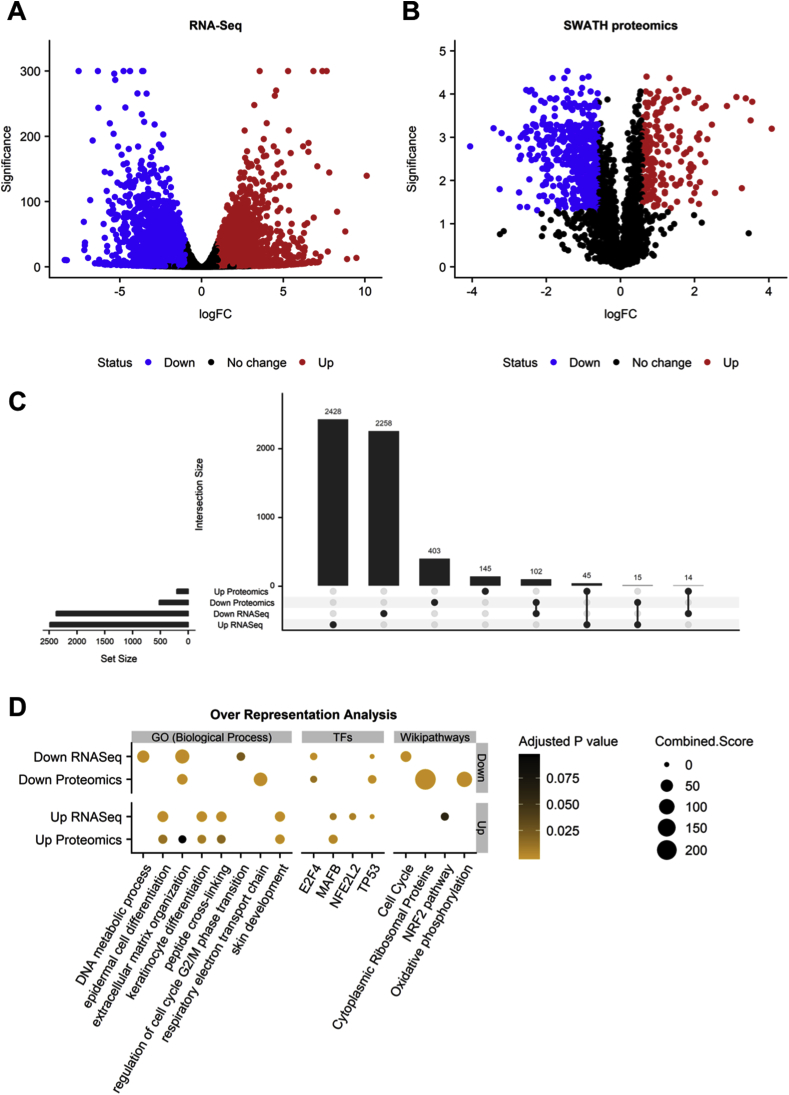
Multi-omic analysis of the response of keratinocytes to CBD. The transcriptomic and proteomic profiling of RNA and protein samples was carried out using RNA-Seq and LC-MS/MS, respectively. (A, B) Volcano plots showing the magnitude (log2 fold change) and significance (-log10 p value) of the changes in the transcriptomic and proteomic comparisons of CBD treated keratinocytes versus controls (n = 3 for RNA-Seq and n = 4 for proteomics). Every point represents a gene/protein and the colour indicates those surpassing the cut-off of an adjusted P value < 0.05 and an absolute fold change >2 (for genes) or > 1.5 (for proteins). For RNA-Seq, a small value (1e-300) was added to p values in order to avoid logarithms of zero at plotting. (C) Upset plot indicating the overlap between the sets of up or down regulated genes and proteins as a bar plot over a coincidence histogram. (D) Over-representation analysis results. The dot plot indicates with a point the significant over-representation of a given term, transcription factor or pathway in a group of up or down regulated genes/proteins (Fisher Exact Test adjusted P < 0.1). While the colour indicates the adjusted P value of the enrichment, the size of the point represents the enrichR combined score.